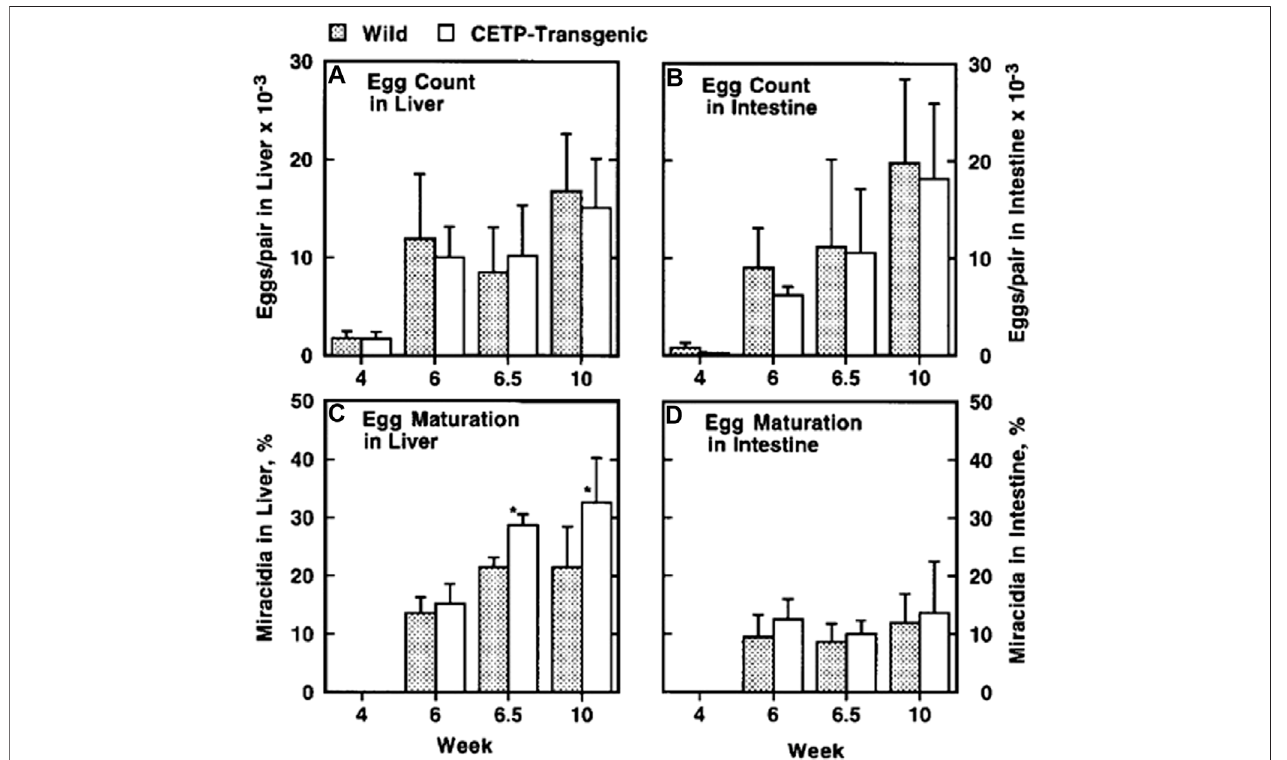
FIGURE 7 | Egg analysis in the mice infected by S. japonicum (Okumura-Noji et al., 2001). The CETP transgenic and wild-type mice were infected. Total eggs recovered were counted in the liver and intestine and the egg number per an adult pair of the parasite in the portal vein was calculated for individual mouse. Egg embryonation to miracidia was microscopically counted for 100 eggs, for the liver and intestine in each mouse. (A,B) The egg count, in the liver and in the intestine. No difference was observed between wild type C57BL/6 mice and human CETP-transgenic mice. (C,D) The egg embryonation as indicated by the relative content of miracidia. In the CETP-transgenic mice, the eggs were matured signi fi cantly more in the liver by * p < 0.001, whereas there is no difference in the intestine. N = 10.